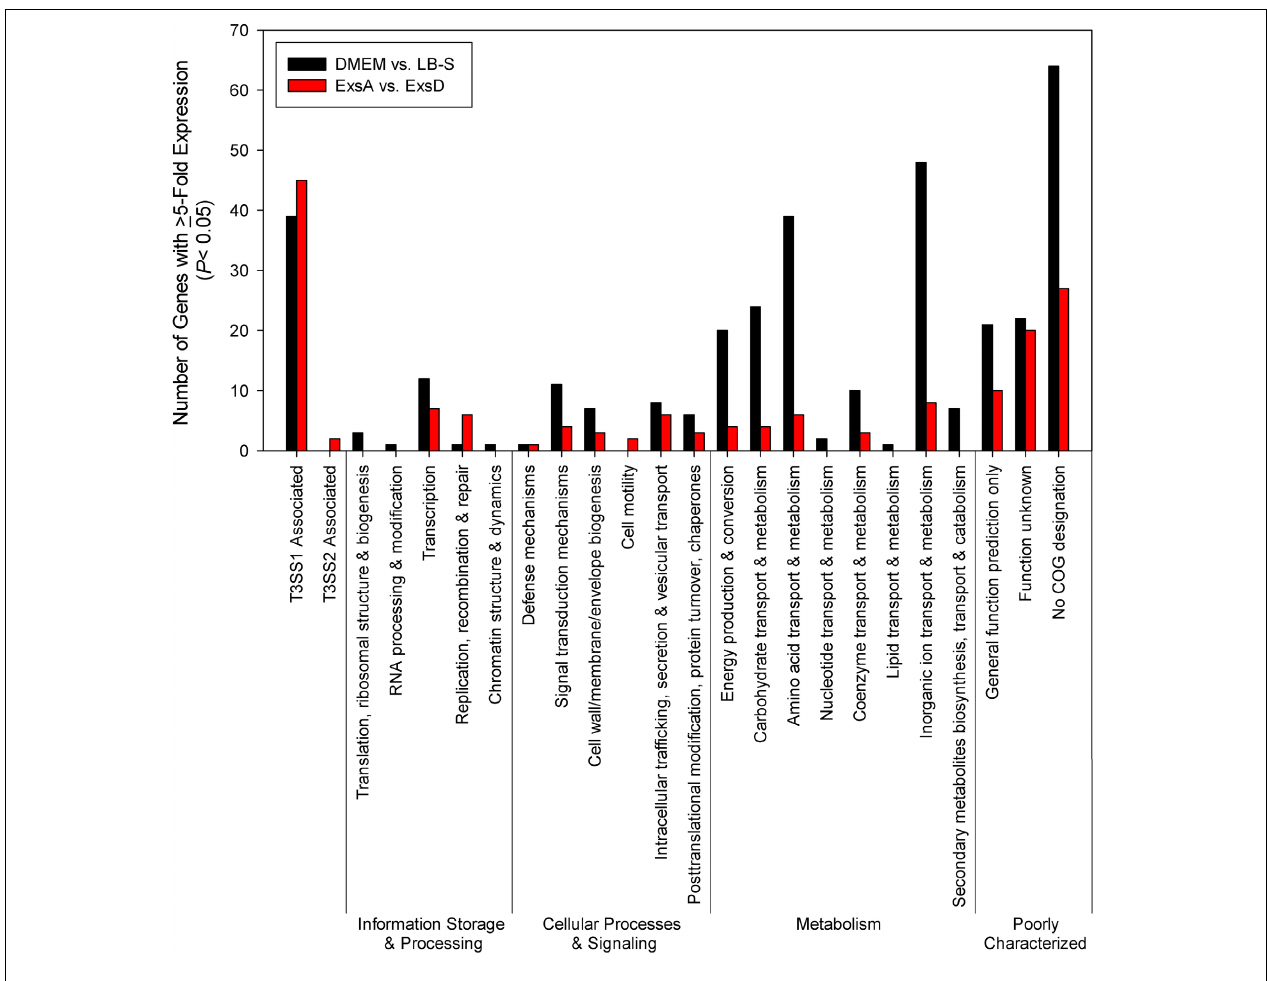
FIGURE 4 | Induction of T3SS1 in DMEM compared to LB-S and in trans exsA expression compared to in trans exsD expression ( n = 2 replicates). Genes were screened for ≥ 5-fold increase in